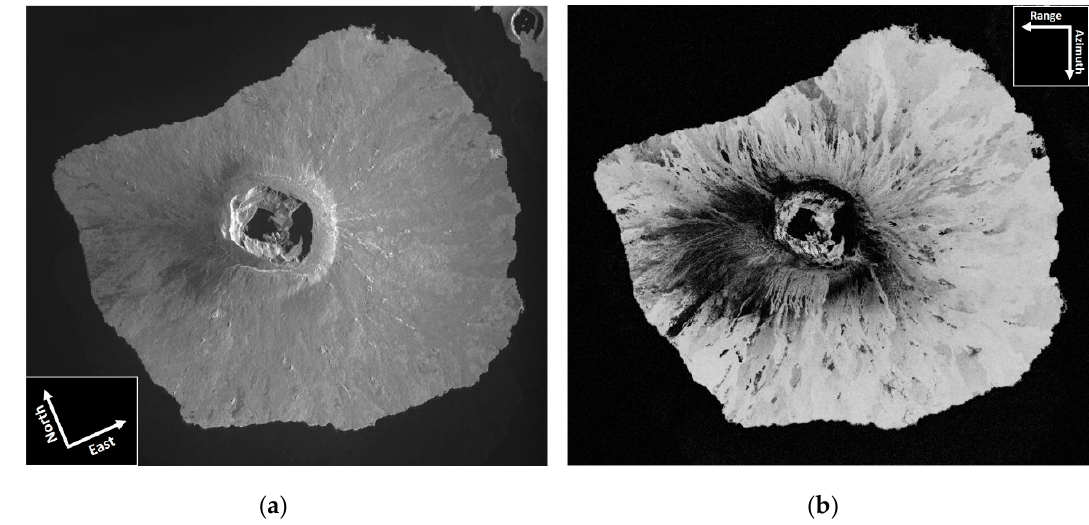
Figure 6. ( a ) Multilook COSMO-SkyMed image acquired (on 27 April 2018) over Fernandina Island (Galapagos) obtained after coregistration on the reference image (acquired on 11 April 2018); ( b ) coherence between secondary and reference SAR images evaluated after the image coregistration operation. Table 2. Utilized parallel